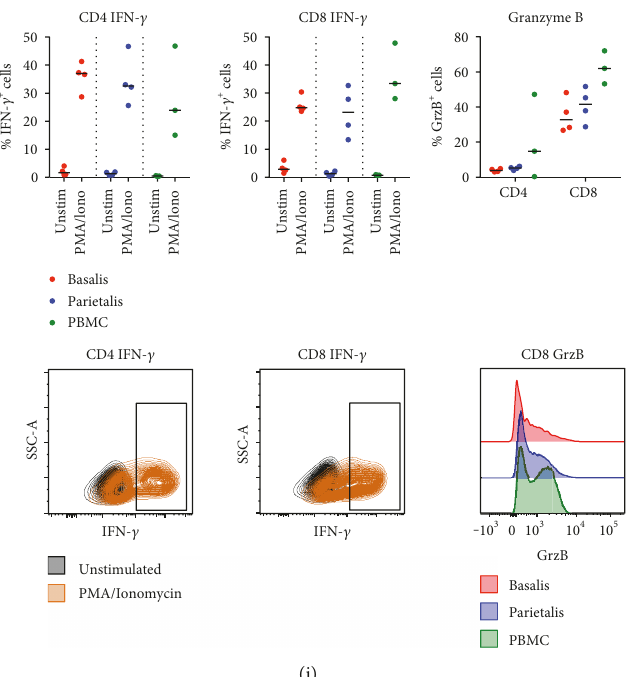
Figure 4: Decidua parietalis contains more activated T cells than basalis. (a) CD4 + and CD8 + T cells were gated according to the expression of CD45RA and CCR7 (gating strategy in (b)) and divided into naïve, central memory (CM), e ff ector memory (EM), or terminally di ff erentiated (TD) subsets ( n = 13 ). (c) Representative histograms showing the expression of the indicated extracellular markers on decidua basalis and parietalis compared to the fl uorescent minus one (FMO) control. Comparisons between decidua basalis and parietalis CD4 + and CD8 + T cells regarding the expression of CD69 (d), CD25 (e), HLA-DR (f), CD127 high (g), CXCR3 (h), and CCR6 (i) ((d, e) and (i) n = 12 , (f, g) n = 11 , (h) n = 13 ). (j) Paired mononuclear cells from basalis ( n = 4 ) and parietalis ( n = 4 ) were stimulated for 5 hours with PMA/ ionomycin or left unstimulated. Data on cells from healthy controls (PBMC) were included as controls ( n = 3 ). Intracellular expression of interferon- γ (IFN- γ ) and granzyme B (GrzB) was determined by fl ow cytometry. T cells were divided into CD4 + (upper left) and CD8 + (upper middle), representative contour plots below the respective cell subset. GrzB was measured in unstimulated samples only (upper right), representative histograms shown in the bottom right corner. Line in graphs depicts the median among values. Comparisons between the paired samples were made using the nonparametric Wilcoxon test. ns=not signi fi cant; ∗ p < 0 05 ; ∗∗ p < 0 01 ; ∗∗∗ p < 0 001